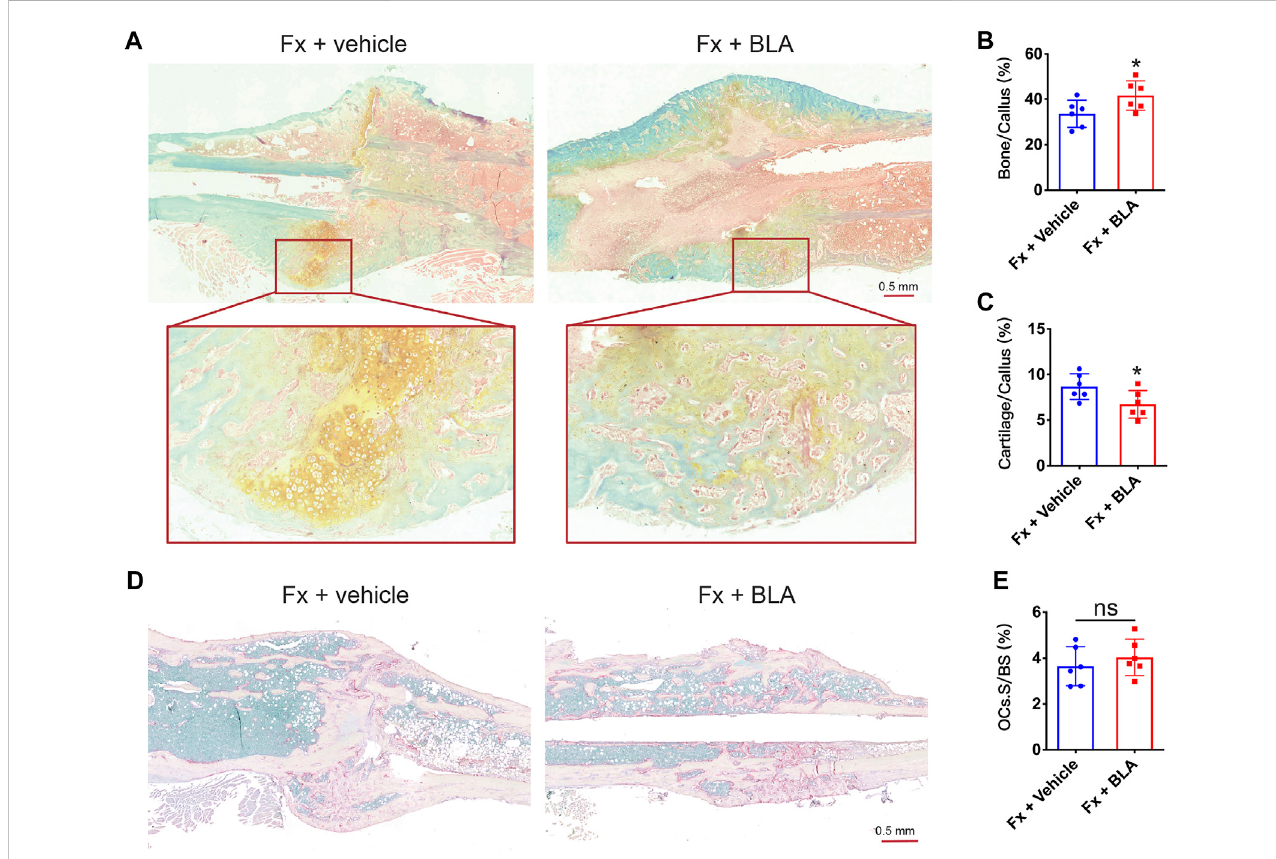
FIGURE 5 TheeffectsofBLAonbonemineralization (A) Representativesafranin-O/fastgreenstainingimagesoffracturedtibiasectionsfromvehicleorBLAtreated mice on day 28 after fracture. (B, C) Quantitative analysis of (B) bone fraction and (C) cartilage fraction in the callus of different groups. N = 6 per group. (D) Representative TRAP stainingimagesoffracturedtibiasectionsonday28after fracture. (E) Quantitative analysisof thefraction ofosteoclasts surface(OCs. S) to bone surface (BS). N = 6 per group. Values are expressed as mean ± SD. Independent-sample t -test: * p < 0.05, when compared with vehicle